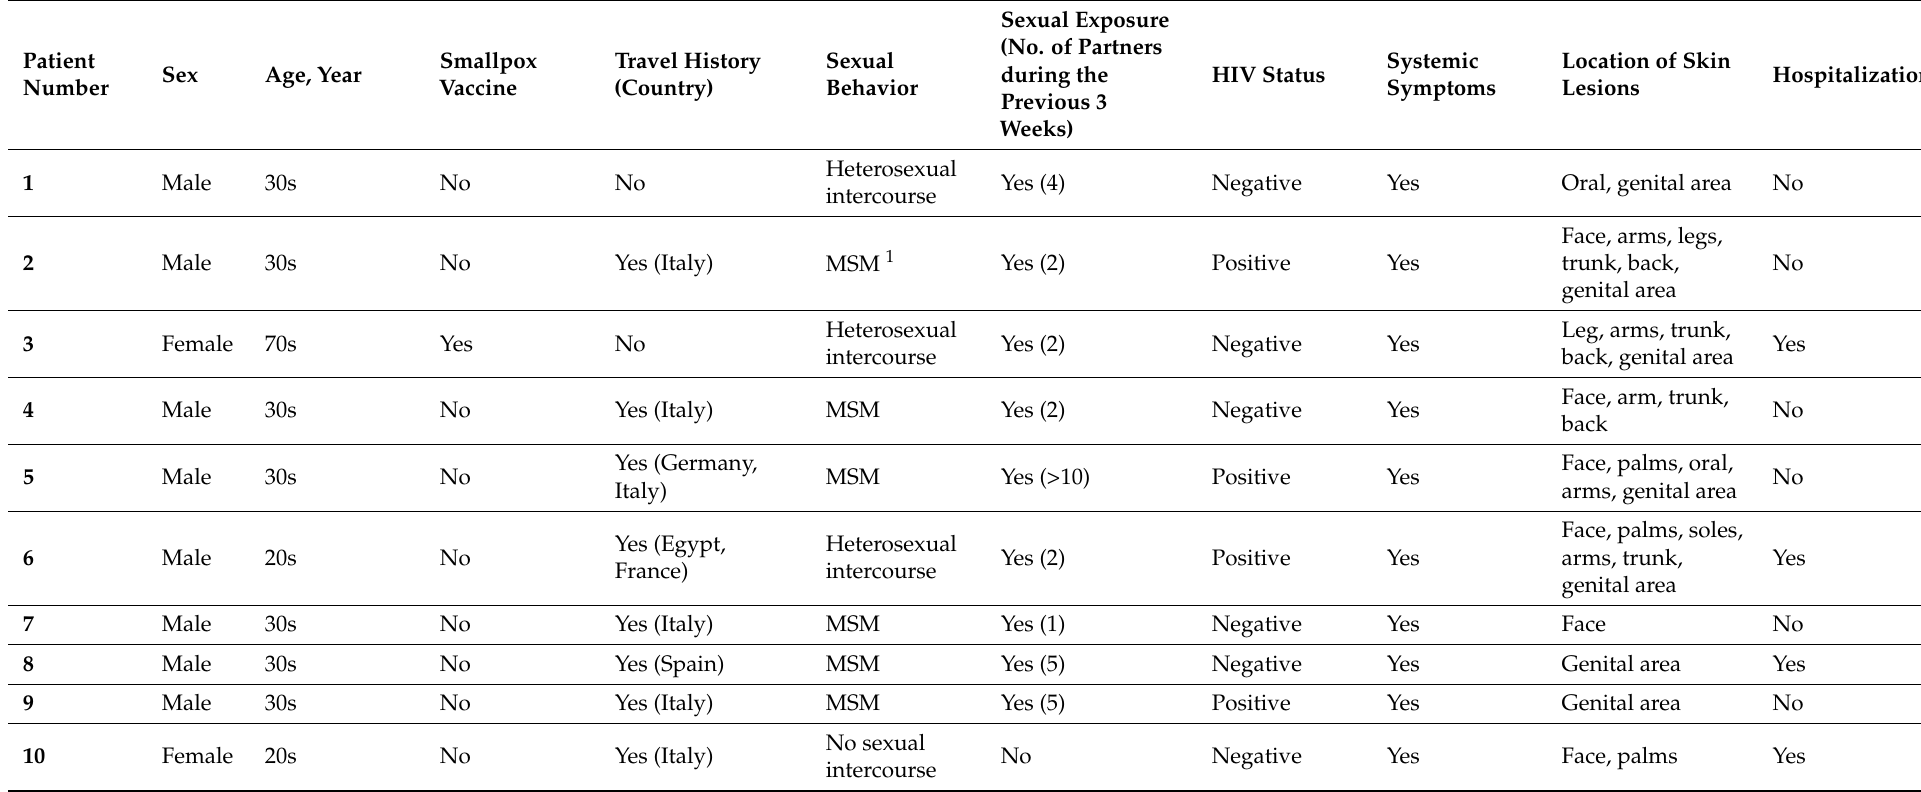
Table 1. Clinical and epidemiological characteristics of patients in the Apulia region (Southern Italy) with